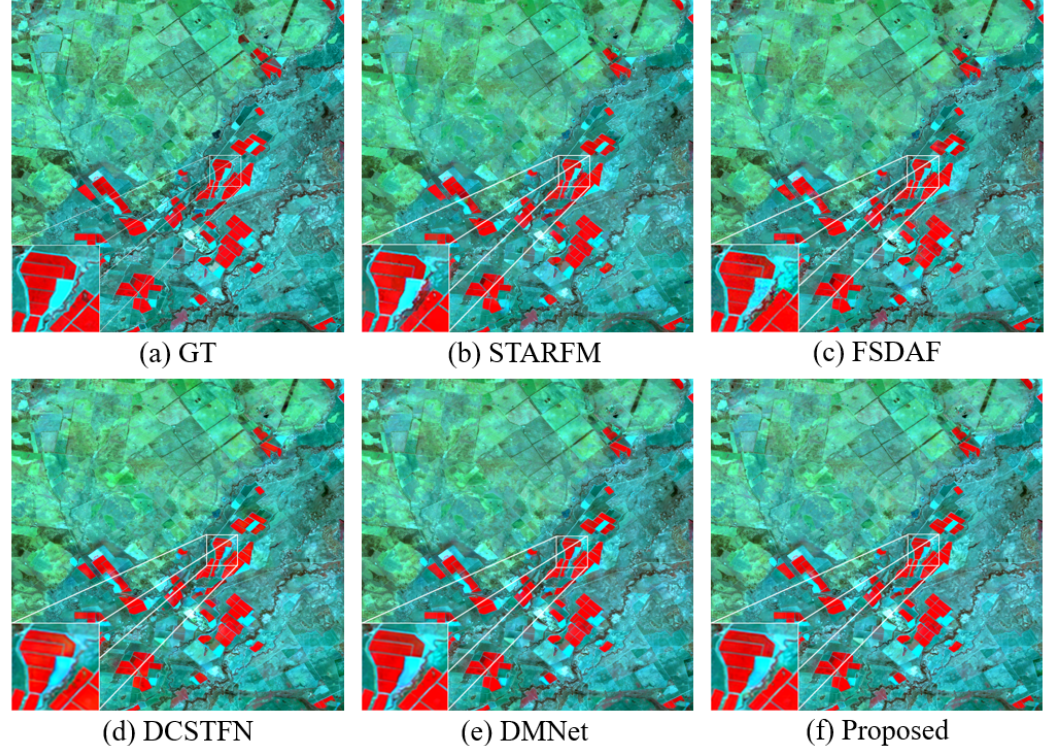
Figure 9. Predicted results of the high-spatial resolution image (2 March 2005) on the LGC [46] dataset. Additionally, comparison methods include STARFM [13], FSDAF [21], DCSTFN [27] and DMNet [18], which were represented by ( b – e ) in the figure, respectively. Moreover, the GT is the ground truth represented by ( a ), and ( f ) is our proposed STF